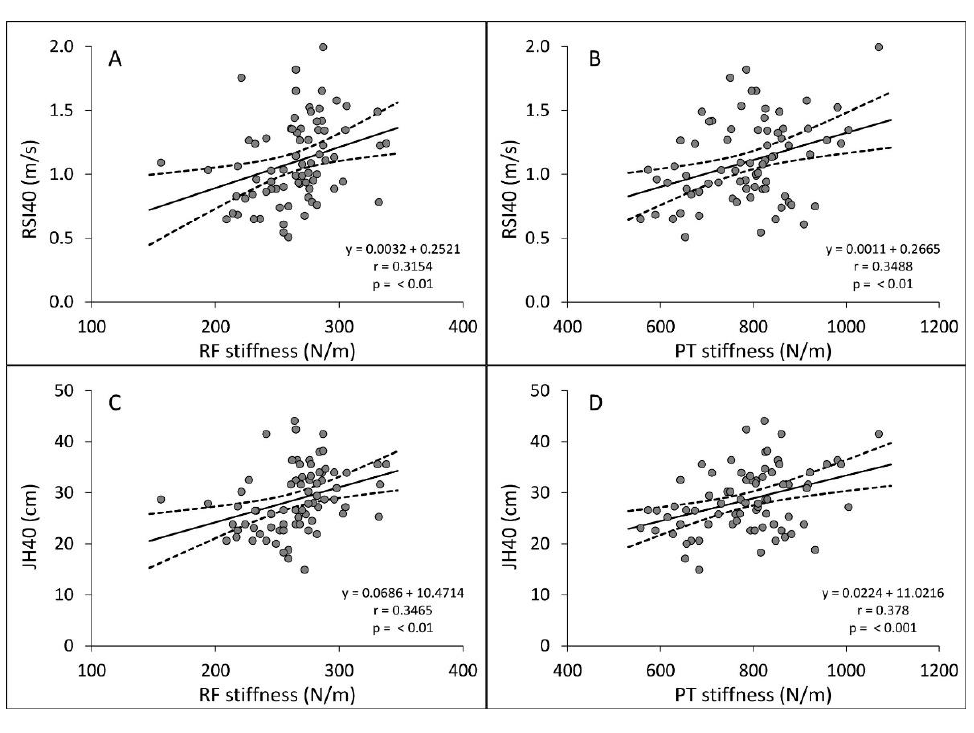
Figure 2. Scatterplots illustrating the significant correlations between Jump Height (JH40) and Reactive Strength Index (RSI40) during the drop jump at 40 cm, with the stiffness of Rectus Femoris (RF) and Patellar Tendon (PT): ( A ) RF stiffness and RSI40; ( B ) PT stiffness and RSI40; ( C ) RF stiffness and JH40; and ( D ) PT stiffness and JH40. The solid lines represent the regression lines. The 95% confidence interval of the correlations is represented by dashed lines. The regression equations are shown in the bottom-right angle of each scatterplot, along with the r value and significance level of